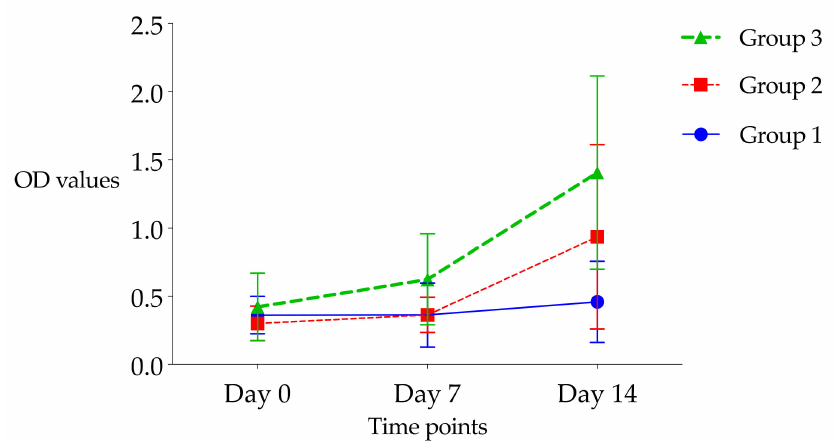
Figure 9. Mean IgG level in sera samples taken on days 0, 7, and 14. IgG level was measured using an anti-FaeG ELISA and depicted as optical density (OD) at 450 nm. The error bars indicate standard deviation. Group 1, negative group (not infected); Group 2, positive group (infected and not treated); Group 3; test group (infected with F4 ETEC and anti-F4 L. lactis added to the meals from day 0 to day